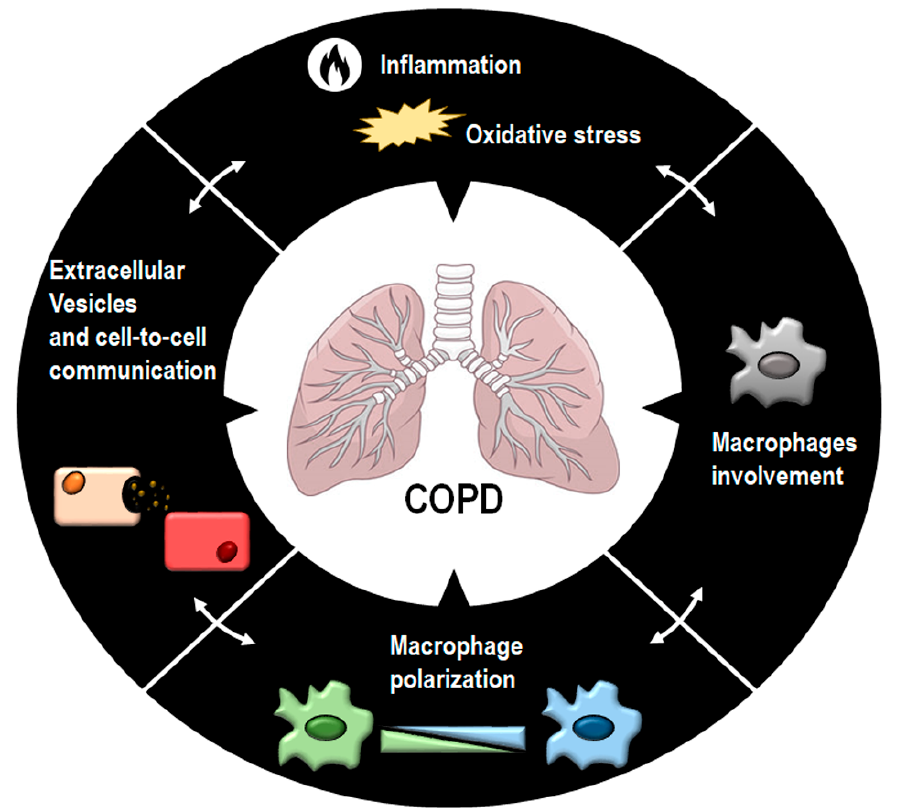
Figure 1. A schematic overview of the principal factors influencing COPD onset and development. COPD is a complex disease due to the concomitant action of multiple factors. In this scenario, macrophage activation and polarization, oxidative stress, and EV-driven signaling could contribute synergistically to COPD insurgency and progression.